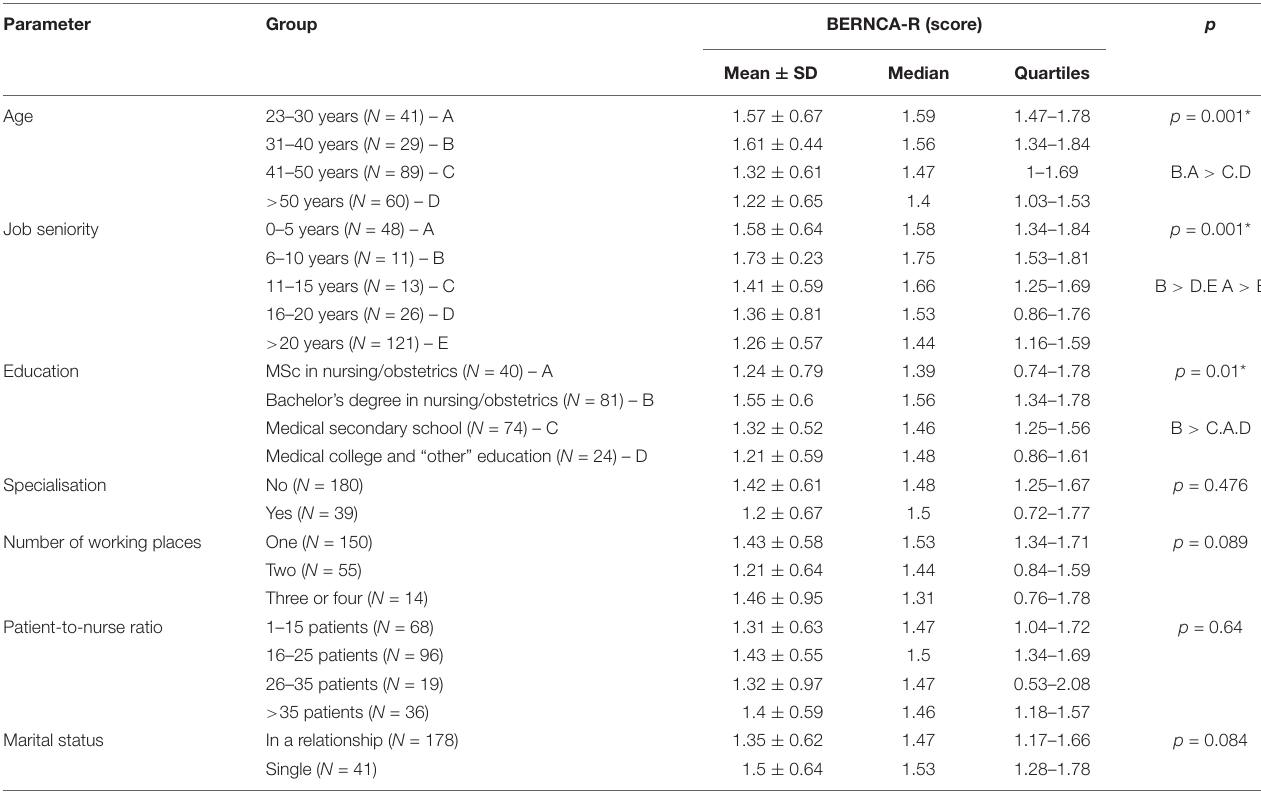
TABLE 2 | Demographic characteristics of the study group compared to the rationing of nursing care.